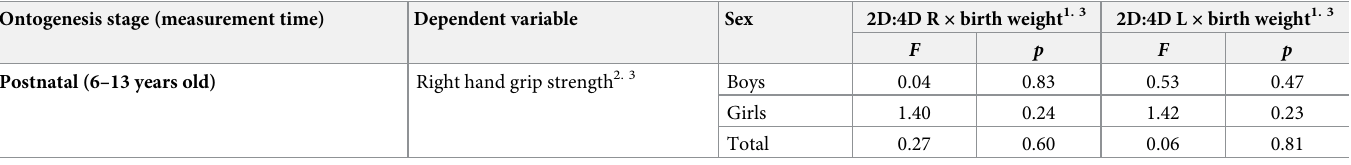
Table 6. Assessment of significance of the interaction between 2D:4D R & L and birth weight explaining right hand grip strength variability in children during post- natal ontogenesis. Ontogenesis stage (measurement